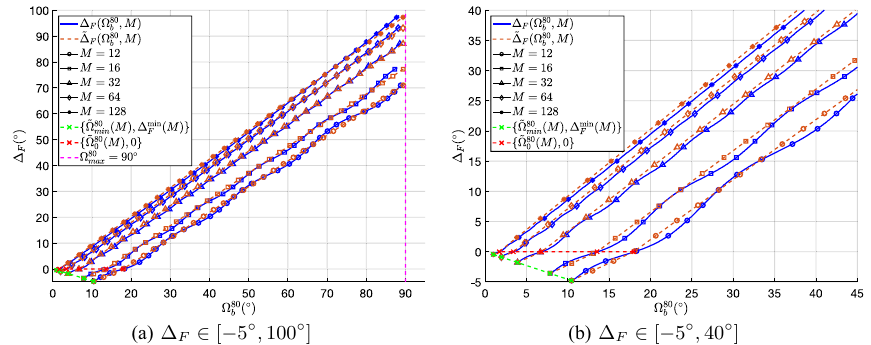
12,16,32,64,128 M b for ∈ {